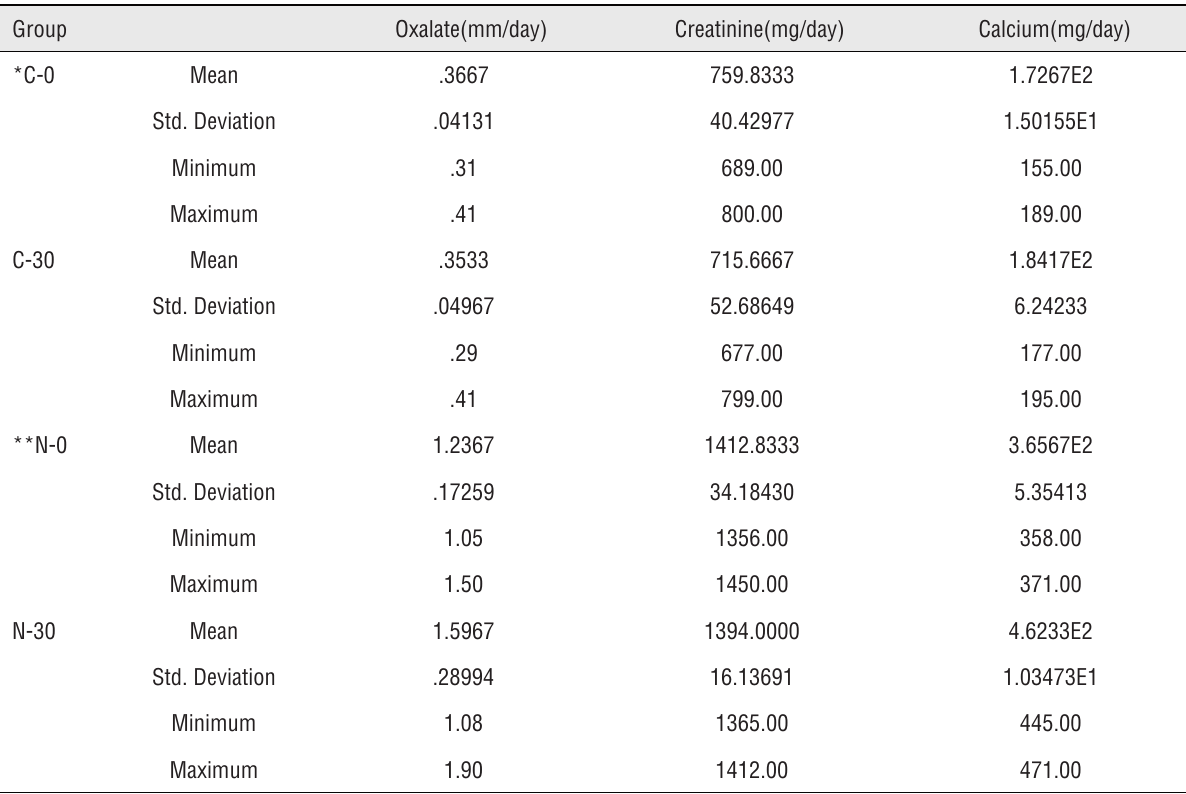
Table 1 - Urinary Oxalate, Calcium and Creatinine levels in Positive and Negative Control groups in 0- and -30 days.